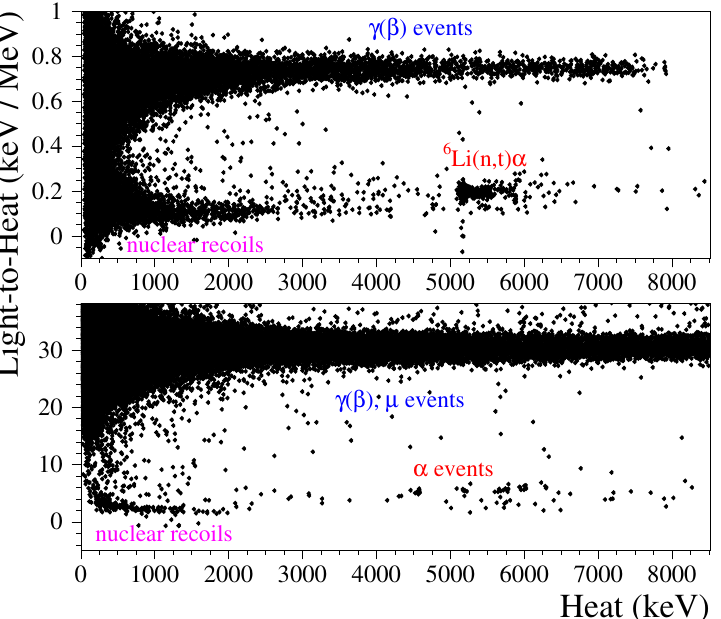
Figure 5. Energy distribution of the L / H parameter of nuclear events detected by scintillating bolometers based on a 213 g 100 Mo-enriched lithium molybdate (top panel; enrLMO-3 in [345]) and a 35 g 116 Cd-enriched cadmium tungstate (bottom panel; [346]), and both accompanied by a Ge LD. The data were acquired over 290 h of AmBe neutron calibration in an underground set-up (top panel) [345] and over 250 h of measurements (190 h of background and 60 h of γ calibration with a 232 Th source) in an aboveground laboratory (bottom panel) [346]. Bottom panel is reprinted with permission from [346]. Creative Commons License CC BY 4.0.